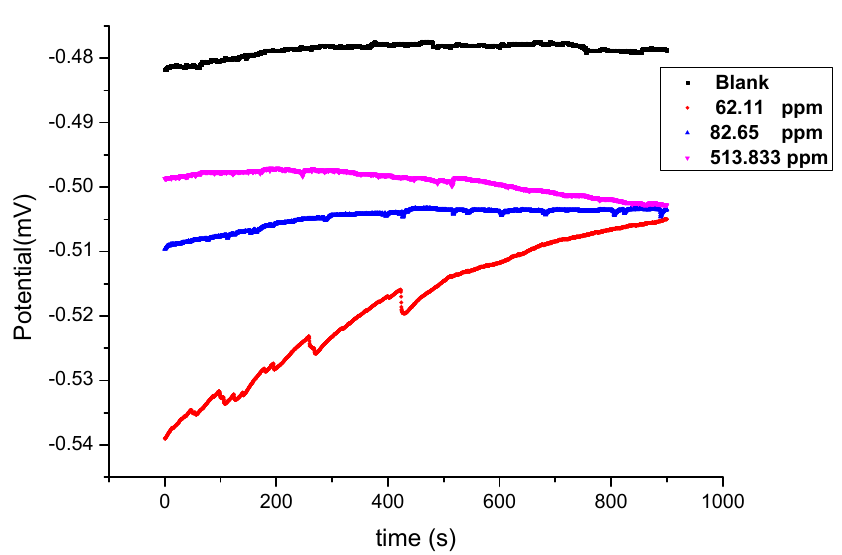
Figure 3. The open circuit potential E OCP plot versus time (s) of C-steel with and without the addition of Harmal extract in 0.25 M H 2 SO 4 medium.